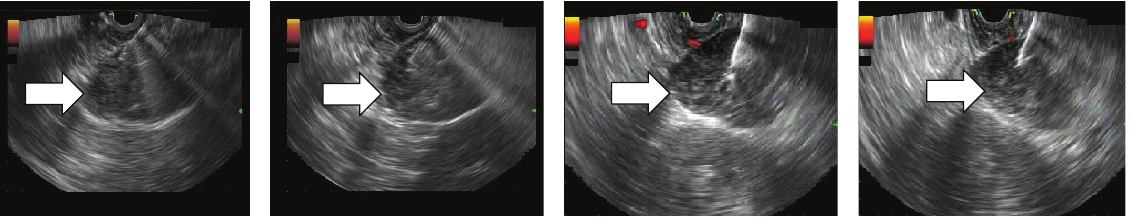
Figure 2: EUS showing hypoechoic mass in the pancreatic uncinate process during FNA procedure.